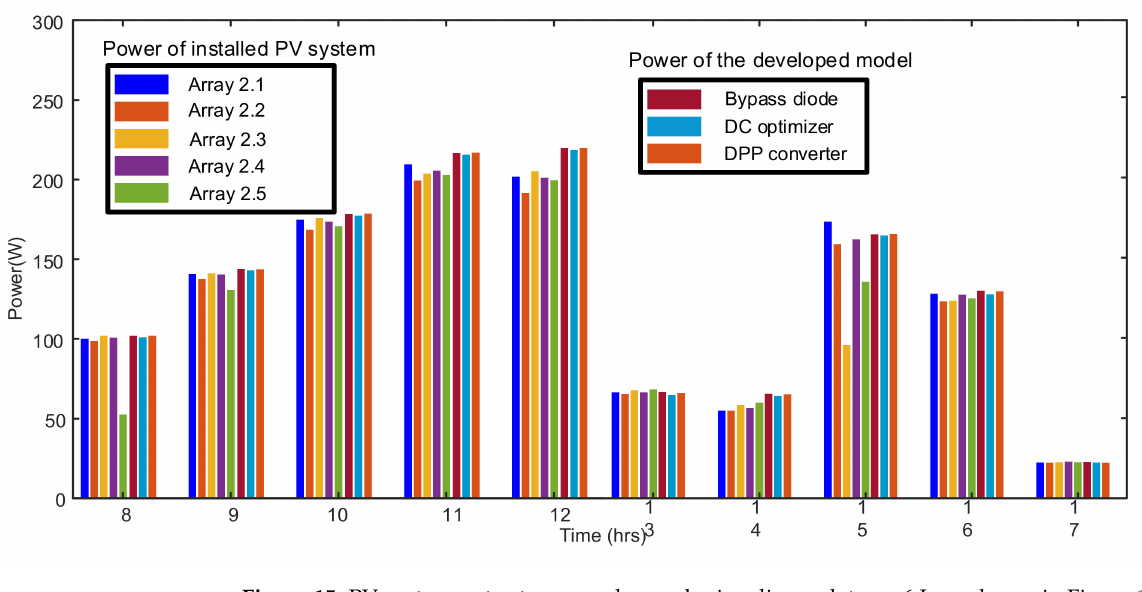
Figure 15. PV system outputs over a day under irradiance data on 6 June shown in Figure 13.